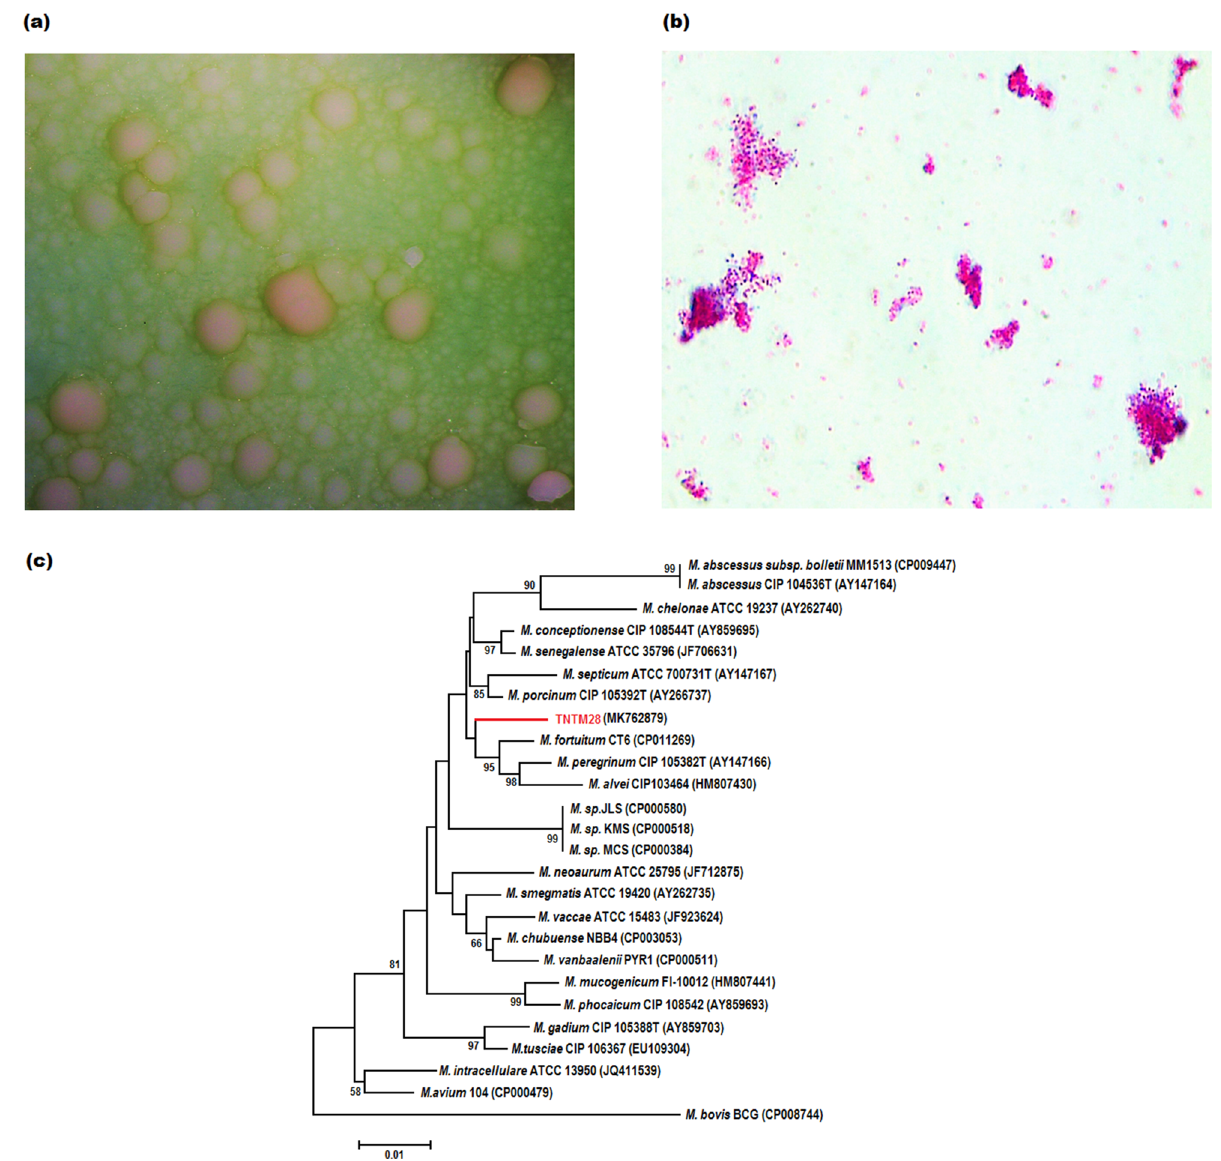
Figure 1. Phenotypic appearance and phylogeny of TNTM28. ( a ) Morphotype of TNTM28 on LJ medium. ( b ) TNTM28 bacilli as observed after Ziehl-Neelsen staining. ( c ) Phylogenetic tree based on rpoB gene sequence highlighting the position of strain TNTM28 relative to other NTM